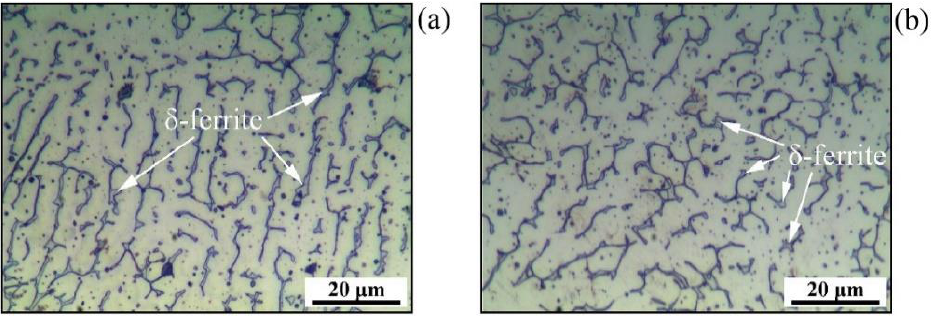
Figure 12. Microstructure of the WAAM 316L stainless steel under ( a ) high heat input and ( b ) low heat input. Reprinted with permission from [55], Copyright 2020 Elsevier.